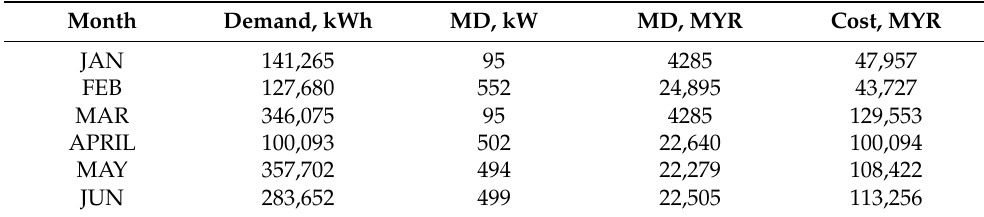
Table 3. Customer electricity profile for the year 2019.